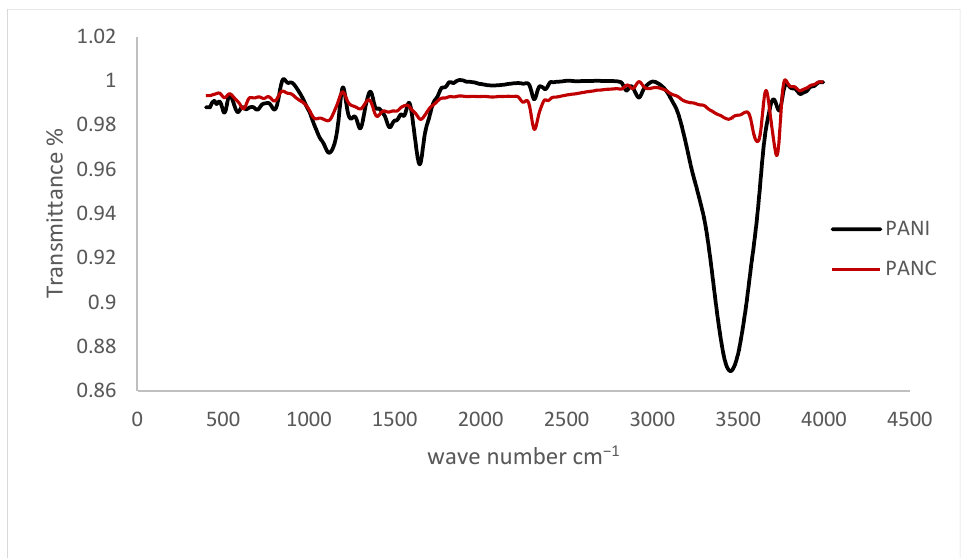
Figure 3. FTIR spectra for the PANI and PANC nanocomposite.